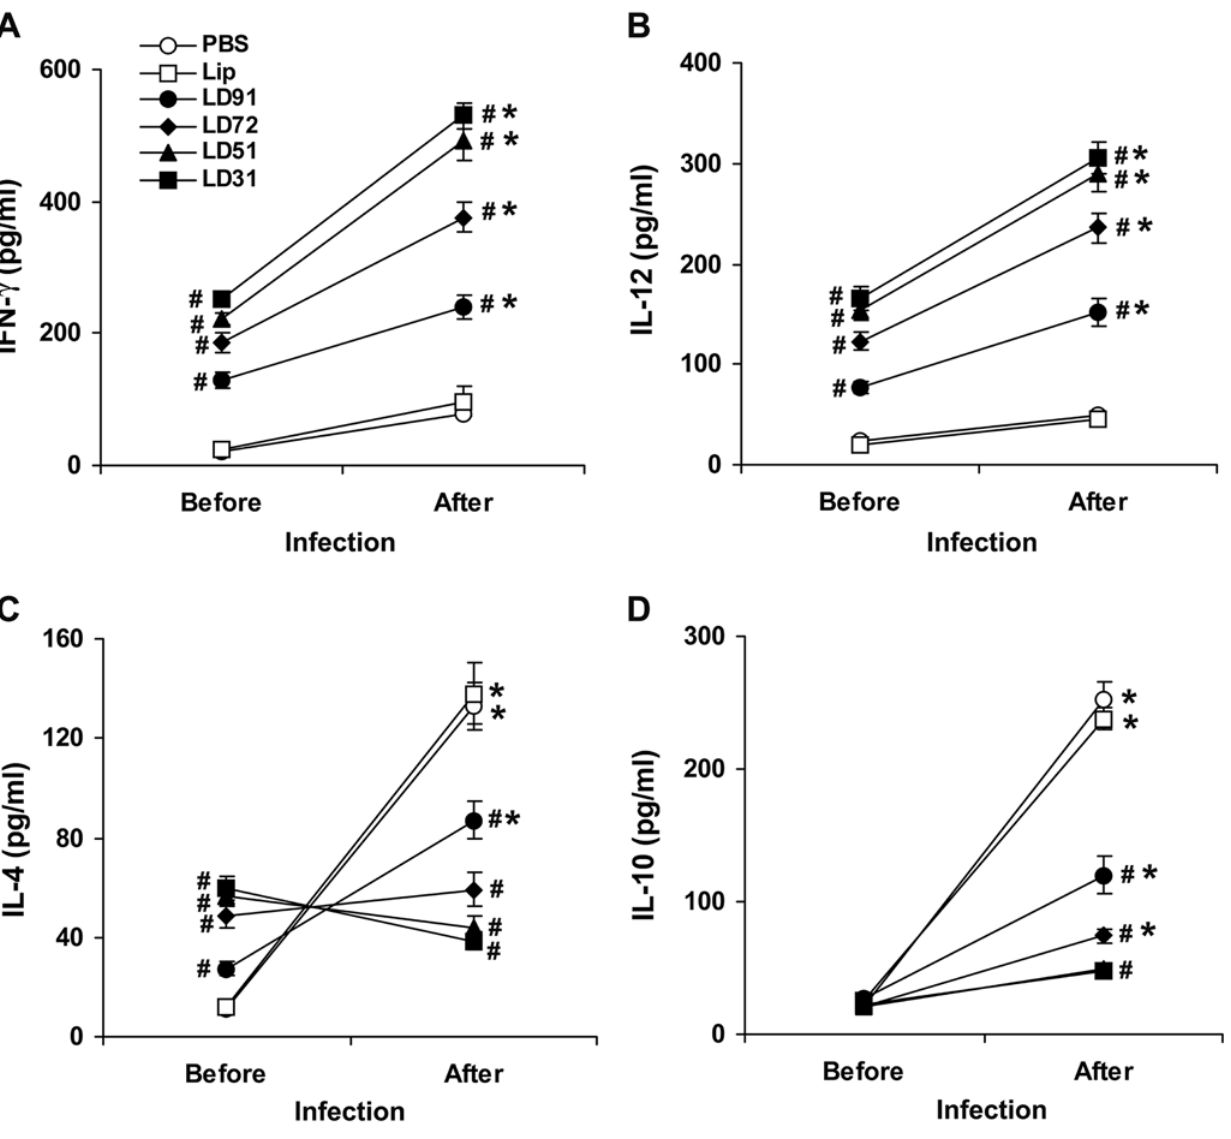
Figure 4. Cytokine responses in BALB/c mice vaccinated with cationic liposomal antigens before and after challenge infection. Ten days after the last vaccination and 3 months after challenge infection spleens were collected and splenocytes were restimulated in vitro with 2.5 m g/ ml of specific antigens. After 72 h supernatants were collected and assayed for IFN- c (A), IL-12 (B), IL-4 (C) and IL-10 (D) levels by ELISA. Each sample was examined in duplicate. The results are shown as the mean 6 S.E. for five individual mice per group, representative of two independent experiments with similar results. # p , 0.0001 in comparison to control groups and * p , 0.001 in comparison to data before infection as assessed by two-way ANOVA and Bonferroni’s